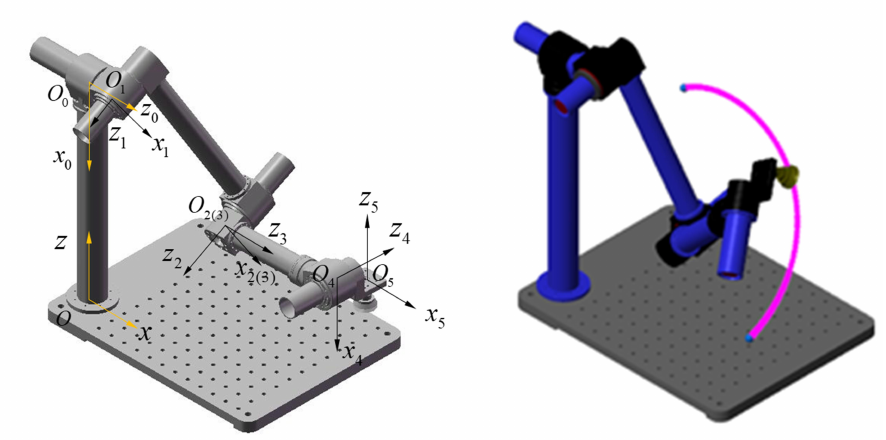
Figure 7. Coordinate systems of a five-dof manipulator and trajectory planning for a PTP